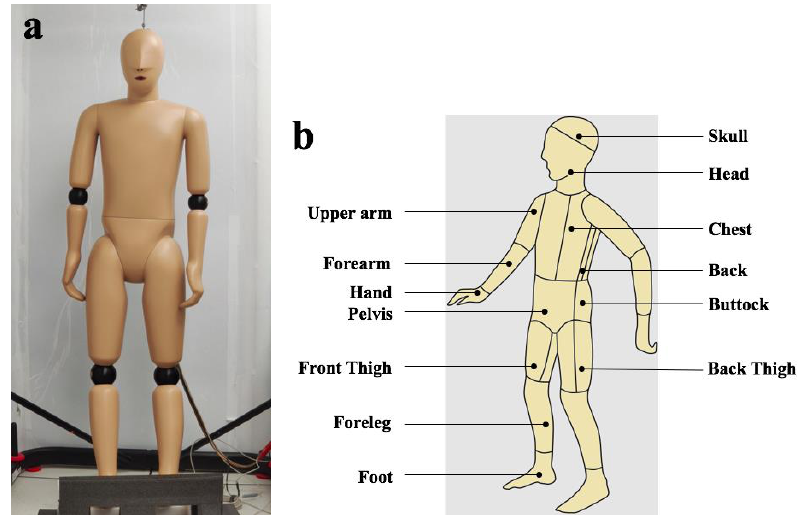
Figure 1. Thermal manikin: ( a ) thermal manikin in standing; ( b ) structure of thermal manikin and block division. Table 1. Body segments and corresponding areas of the thermal manikin. Body Segment Area (m 2 ) Body Segment Area (m 2 ) Left/Right (L/R). Foot 0.053 L/R.